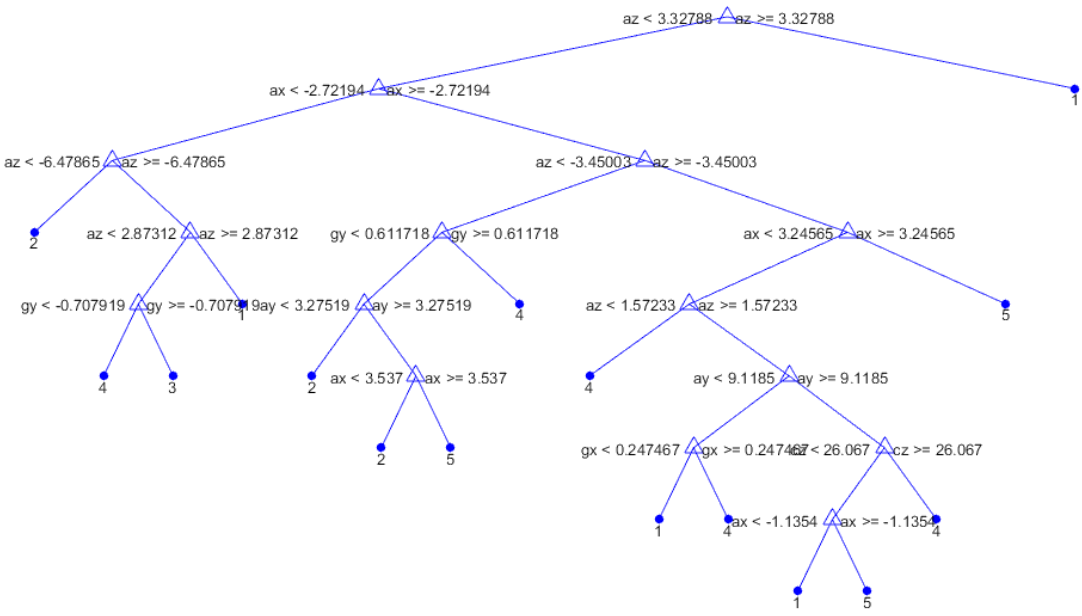
Figure 11. Decision Tree for Medium Tree.